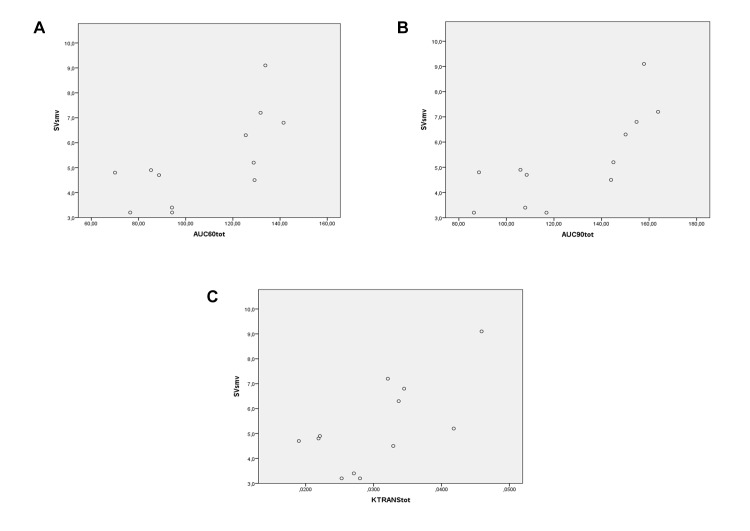
Spearman rank correlation analysis.Correlation between MRI perfusion parameters (on the horizontal axis)—AUC60 (A), AUC90 (B), and Ktrans (C)—in the whole small bowel—of PNH patients and SV of SMV (on the vertical axis).